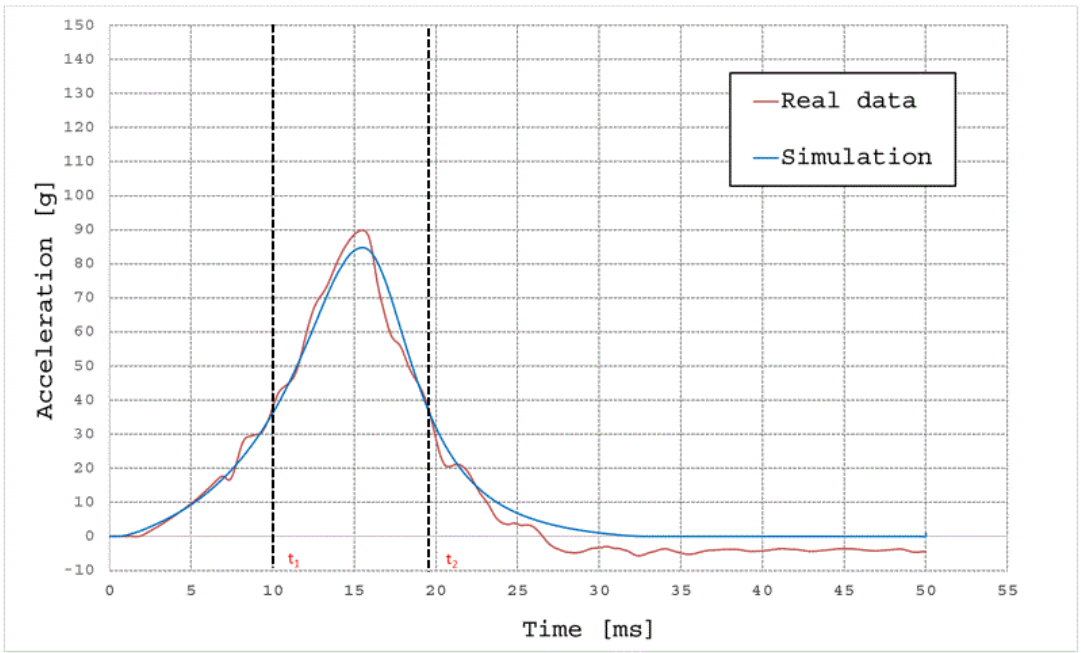
Figure 5. Comparison between the acceleration curve predicted by the simulation and the experimental curve for the EVA 50 mm at 4.5 m/s.